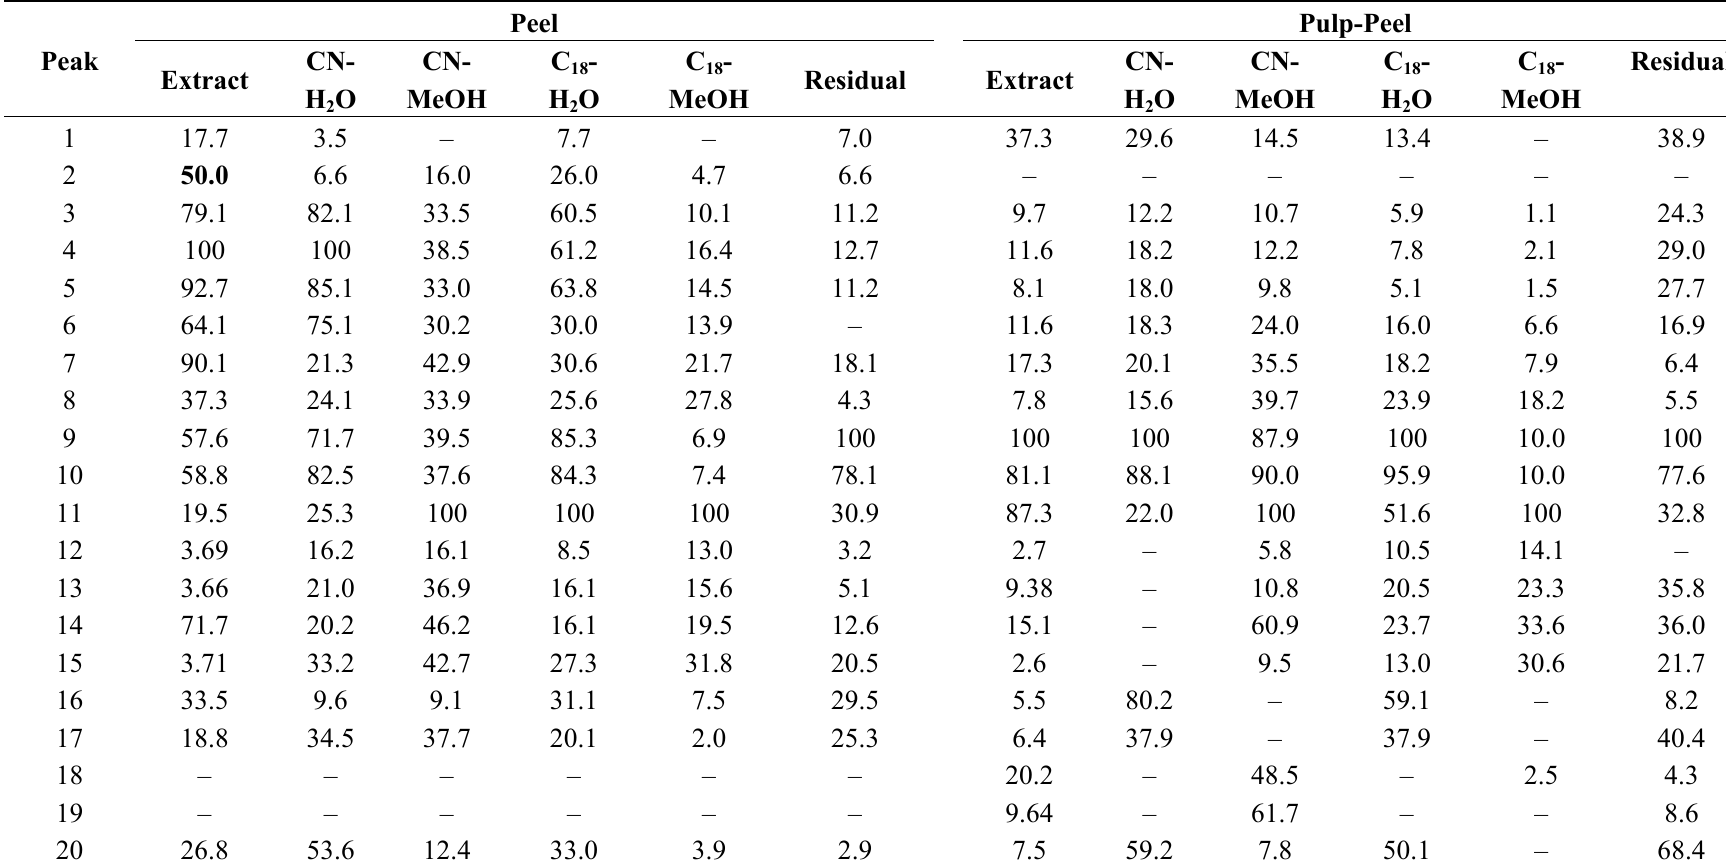
Table 1. Values of the relative abundance a from the MS base peaks for the crude extracts of defatted dabai parts and their SPE fractions.